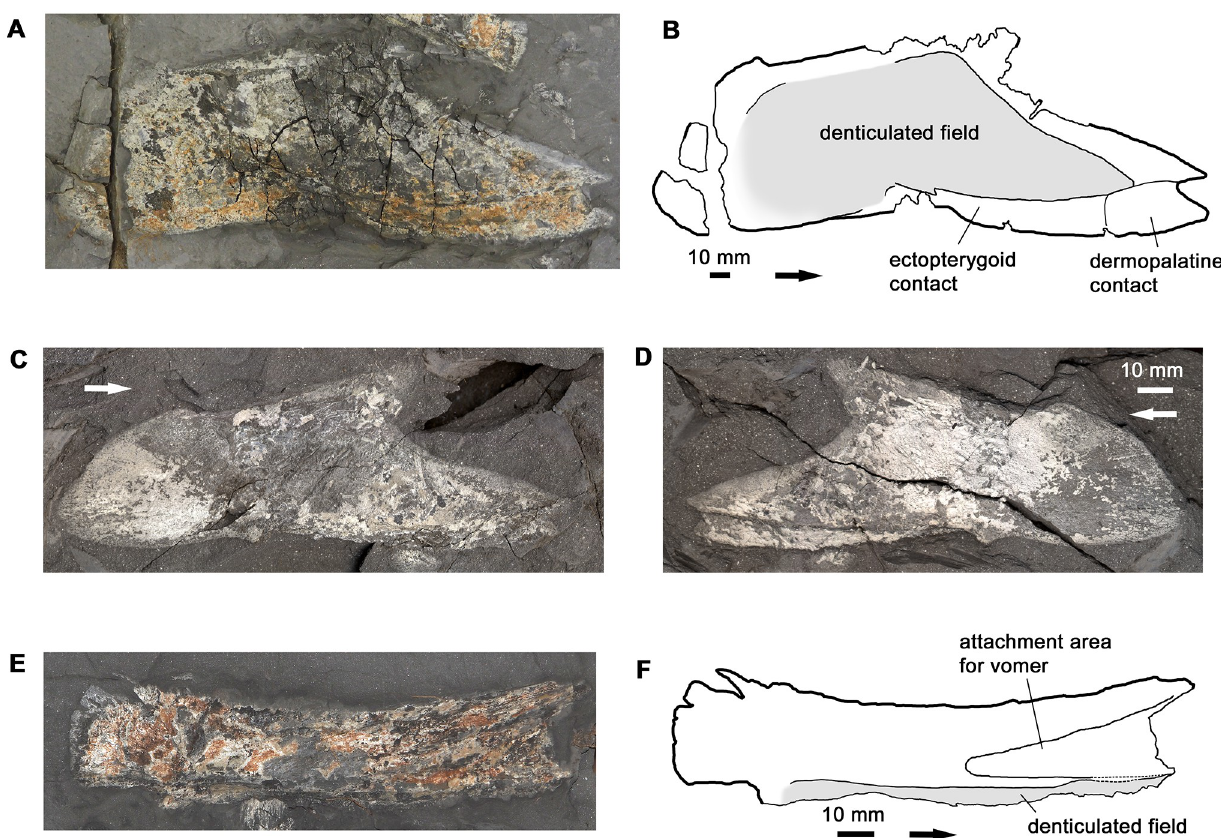
Fig 7. Palatal bones. A-B, photo and interpretative drawing of entopterygoid AM6528a. B also incorporates information from AM6528b. C-D, photos of entopterygoid AM6508b+a, part and counterpart. E-F, photo and interpretative drawing of parasphenoid AM6528a. Graphic conventions as in Fig 4.